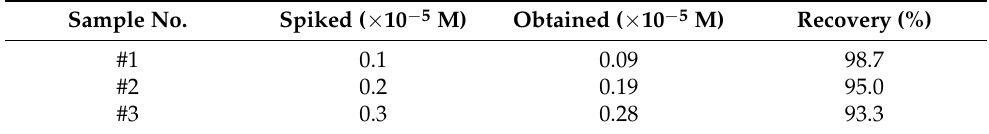
Table 4. CIP detection in urine